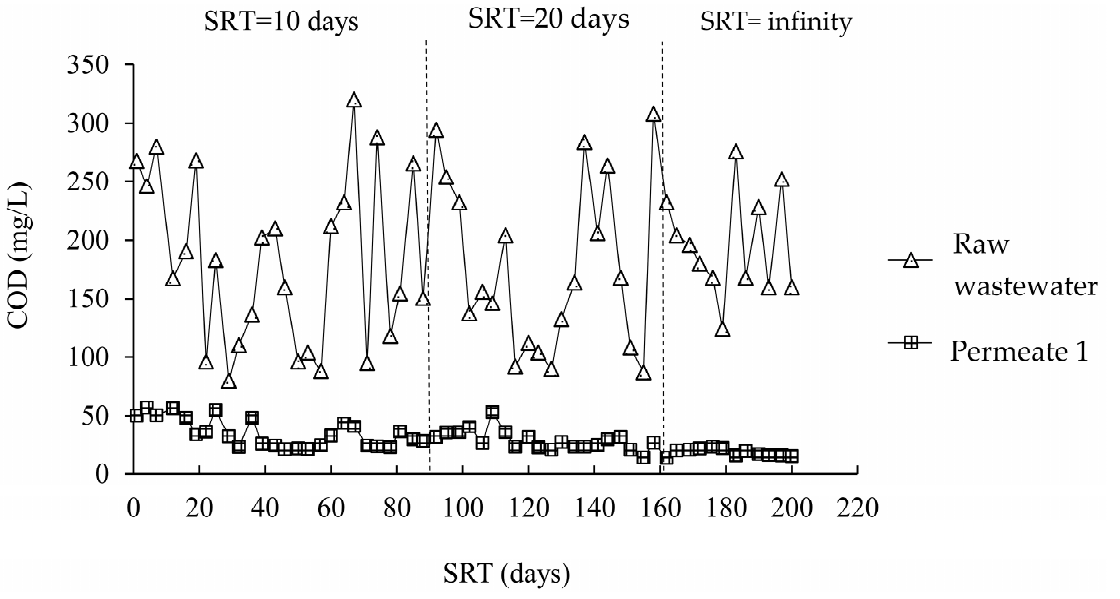
Figure 3. COD concentrations during the experiment at different SRTs in the A/O-MBR system (System 1).